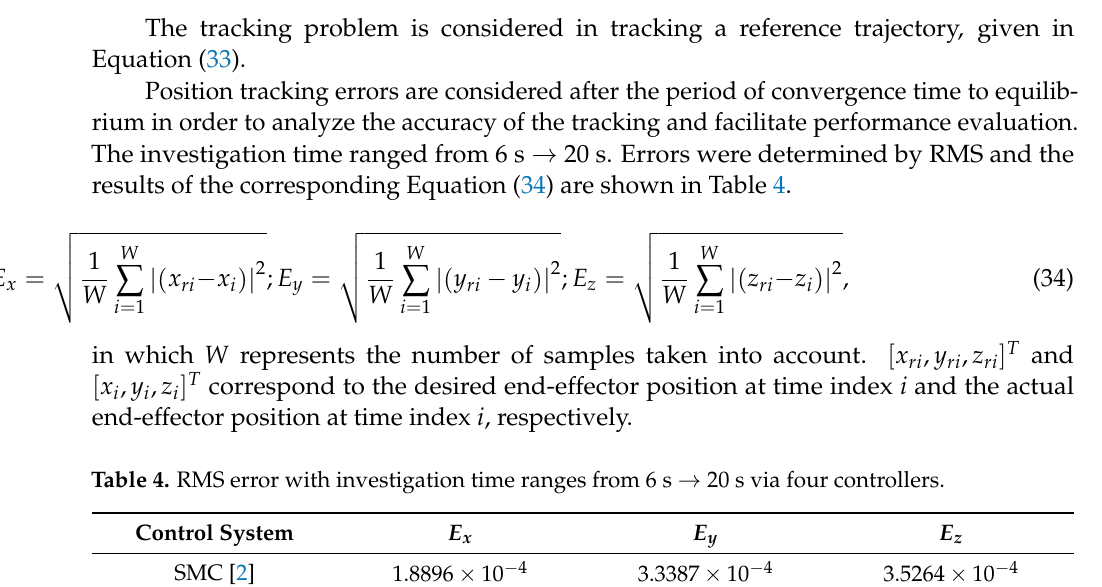
Figure 5. The third joint error comparison between the real trajectory of the robot and the reference trajectory.